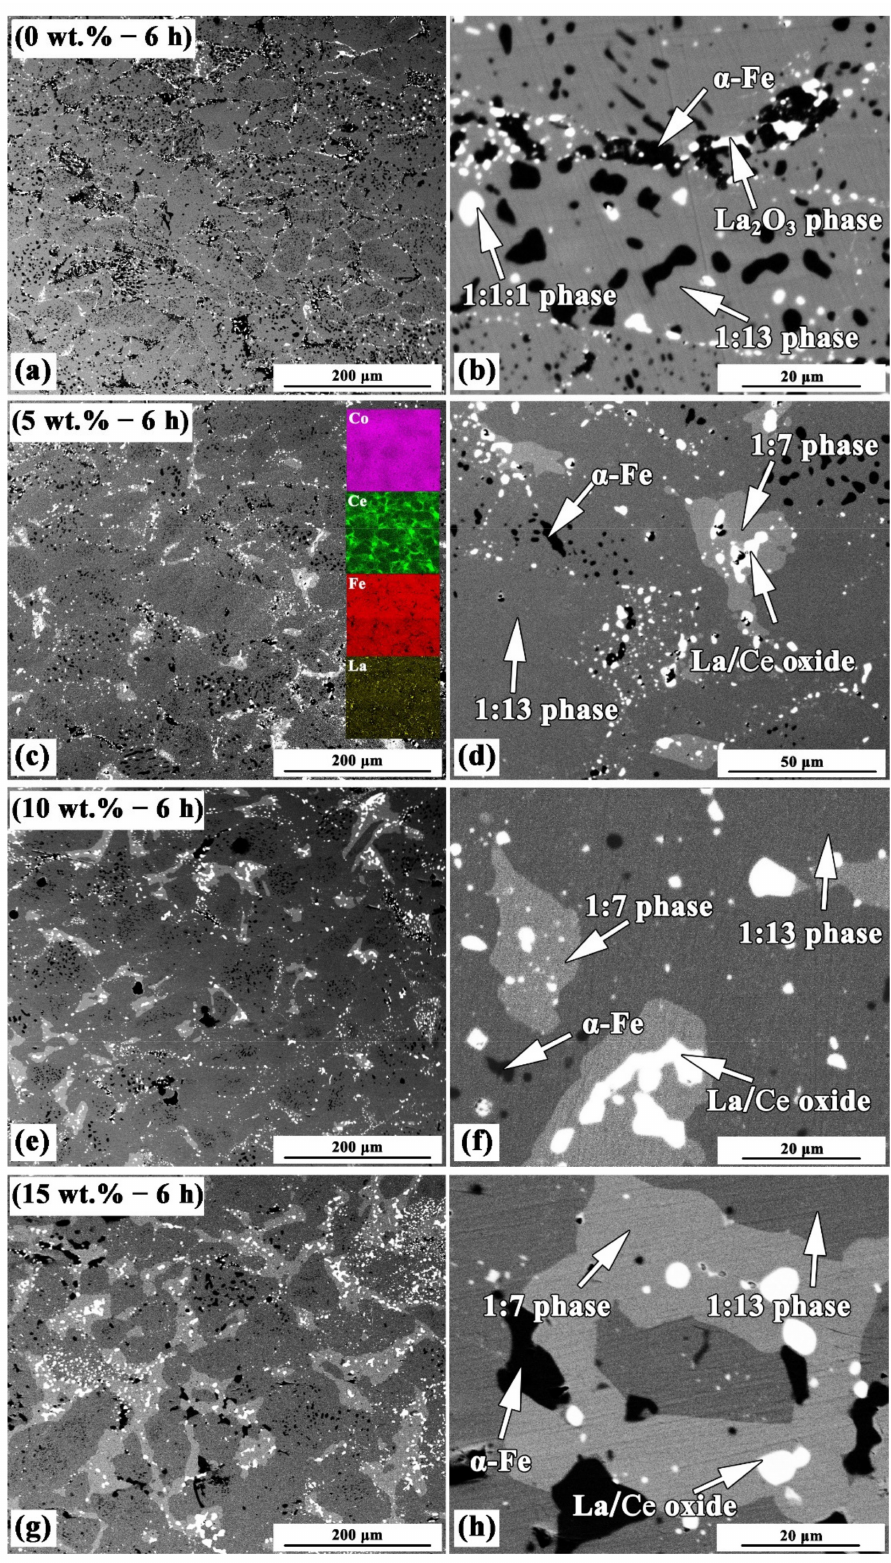
Figure 2. Backscattered SEM micrographs of LaFe 11.6 Si 1.4 / x wt.%Ce 2 Co 7 composites with x = 0 ( a , b ), 5 ( c , d ), 10 ( e , f ), and 15 ( g , h ) sintered at 1373 K for 6 h, respectively. The inset of ( c )shows the mapping results of La, Ce, Fe and Co elements for LaFe 11.6 Si 1.4 /5 wt.%Ce 2 Co 7 composites sintered at 1373 K for 6 h,